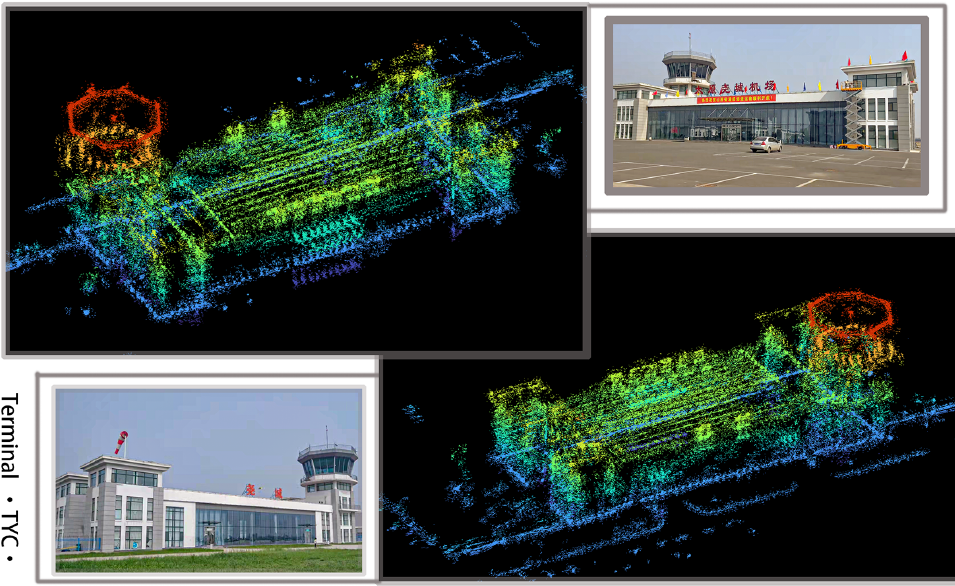
Figure 9. Point cloud for the terminal, with front and behind perspectives, as well as optical photos, are presented together. This figure demonstrates the full 360° 3D reconstruction ability of multi- aspect